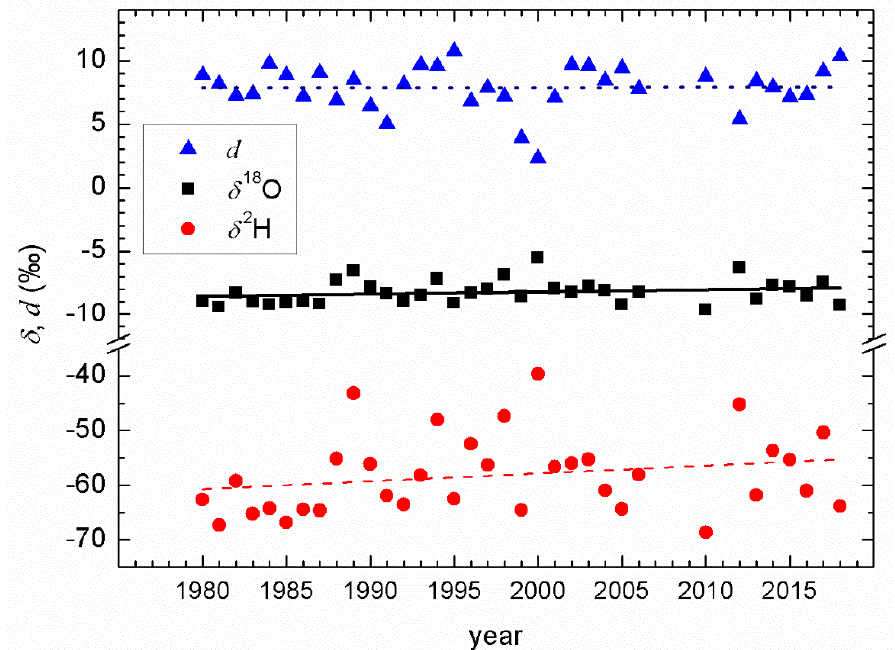
Figure 9. Temporal changes of weighted mean annual δ 18 O, δ 2 H, and d -excess values.